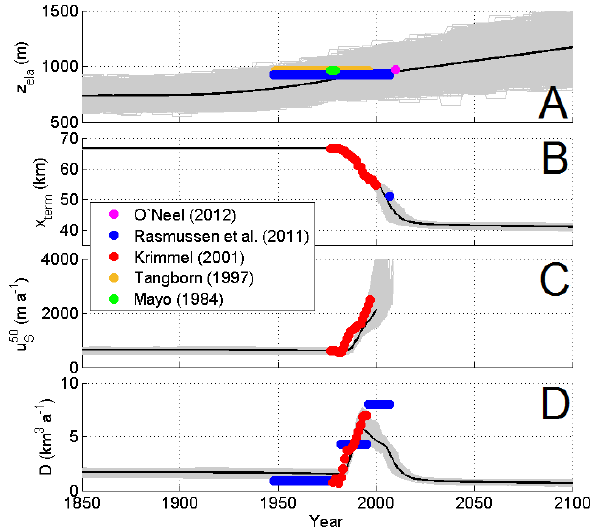
Fig. 13. Modelled (grey lines with ensemble mean in black) and observed or inferred (points; Mayo, 1984; Tangborn, 1997; Krim- mel, 2001; Rasmussen et al., 2011; O’Neel, 2012) time-series of equilibrium line altitude ( z ela ; A ), terminus position ( x term ; B ), ice surface velocity at km50 ( u 50 s ; C ) and inferred calving flux ( D ; D ) at Columbia Glacier over the 1850 to 2100